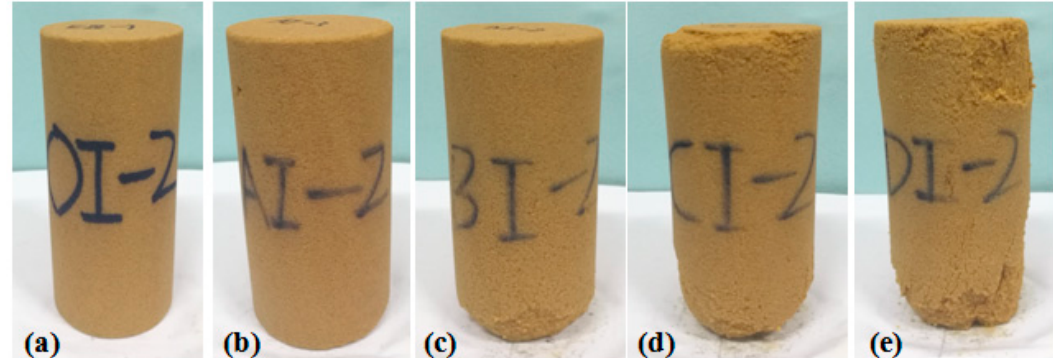
Figure 10. View of sandstone immersed in acid solution with pH of 2.8 after various F–T cycles: ( a ) 0 cycles, ( b ) 10 cycles, ( c ) 20 cycles, ( d ) 30 cycles, ( e ) 40 cycles.